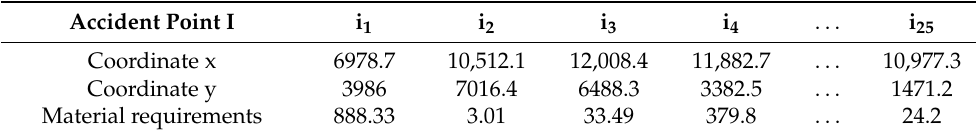
Table 1. Coordinates of the emergency accident points.